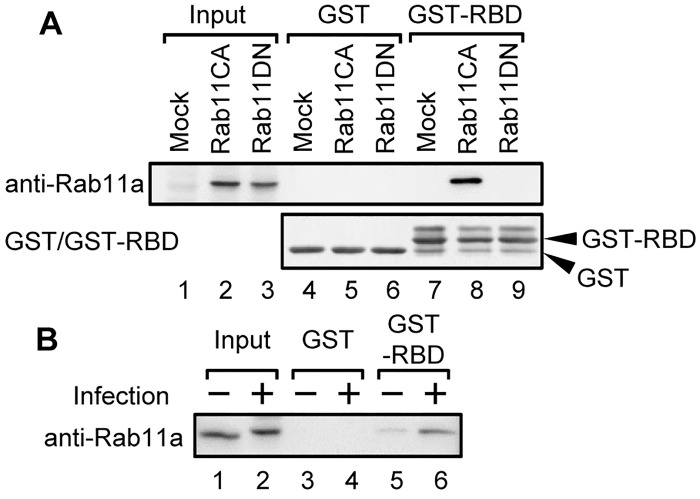
Activation of Rab11a GTPase in infected cells.(A) HeLa cells were transfected with a plasmid expressing either GFP (lanes 1, 4, and 7), GFP-fused Rab11a constitutive active mutant (CA; lanes 2, 5, and 8), or GFP-fused Rab11a dominant negative mutant (DN; lanes 3, 6, and 9). At 24 h post transfection, cell lysates were prepared and subjected to GST pull-down assays with either GST (lanes 4–6) or GST-RBD (lanes 7–9). (B) At 8 h post infection (MOI = 10), mock-infected (lanes 1, 3, and 5) and infected HeLa cells (lanes 2, 4, and 6) were subjected to GST pull-down assays with either GST (lanes 3 and 4) or GST-RBD (lanes 5 and 6). Co-purified proteins were detected by western blotting assays with anti-Rab11a antibody. GST and GST-RBD were detected by CBB staining.